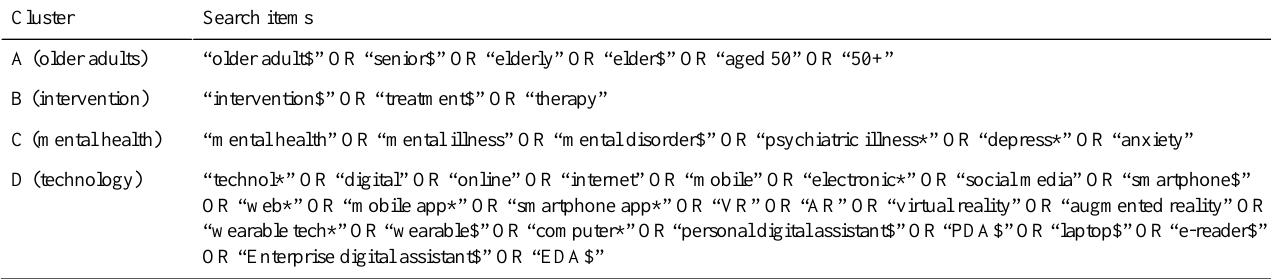
Table 1. Complete list of terms to be input into each database, separated into clusters of main key terms. Search